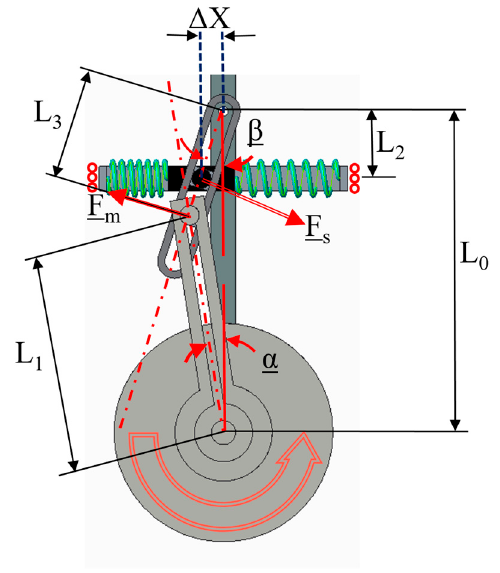
Figure 5. The ARES-XL: diagram showing variables for torque calculations.